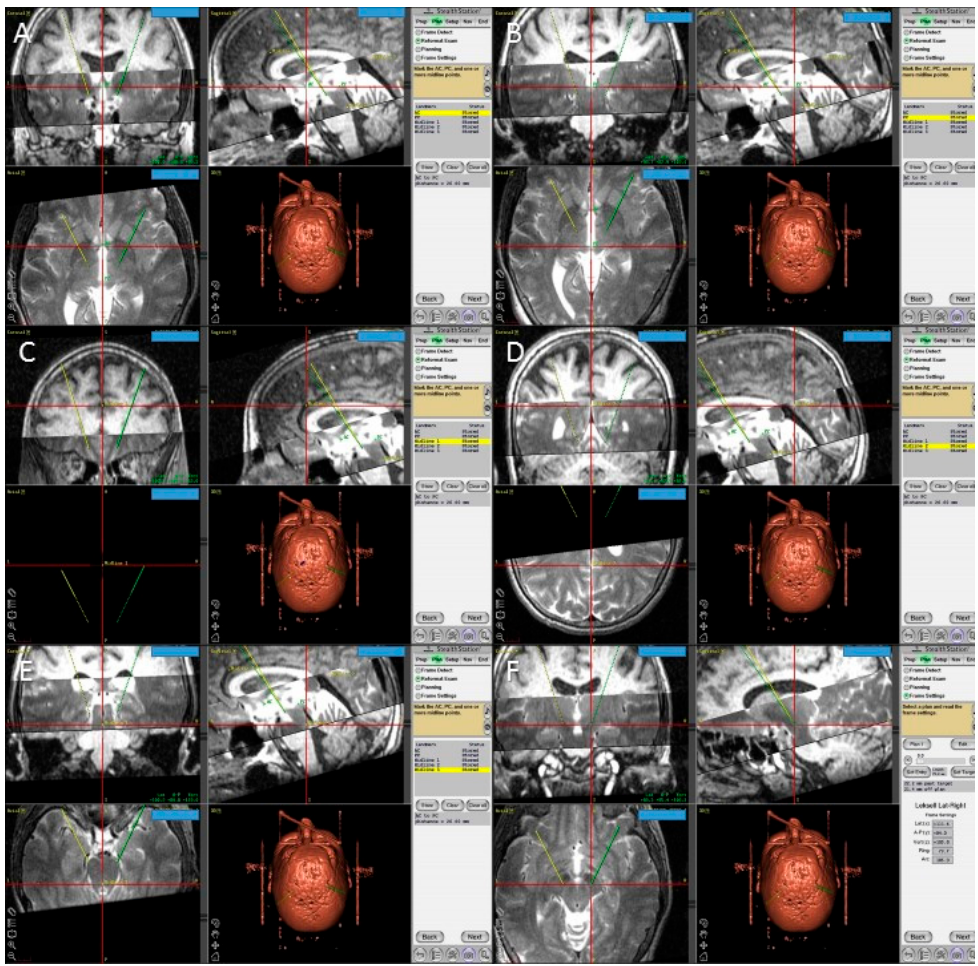
Figure 6. Screen shots from the FrameLink software of the StealthStation showing fused T1 and T2 magnetic resonance imaging (MRI) images of the patient and the planning process with identification of the posterior edge of the anterior commissure ( A ); the anterior edge of the posterior commissure PC ( B ); three midline points ( C – E ); and the final coordinates of the right subthalamic nucleus ( F ).